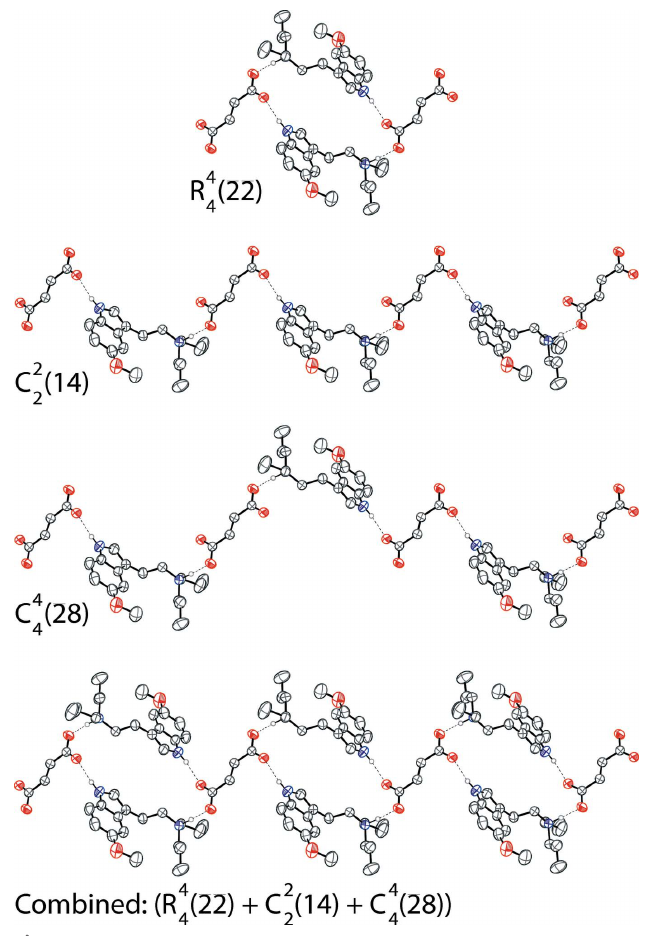
Figure 3 The hydrogen-bonding network along [001], which consists of R 4 rings that are joined together by two parallel C 2 The three components described in graph-set notation and the combined chain is shown. Displacement ellipsoids are drawn at the 50% probability level. Hydrogen atoms not involved in hydrogen bonding are omitted for clarity. Hydrogen bonds are shown as dashed